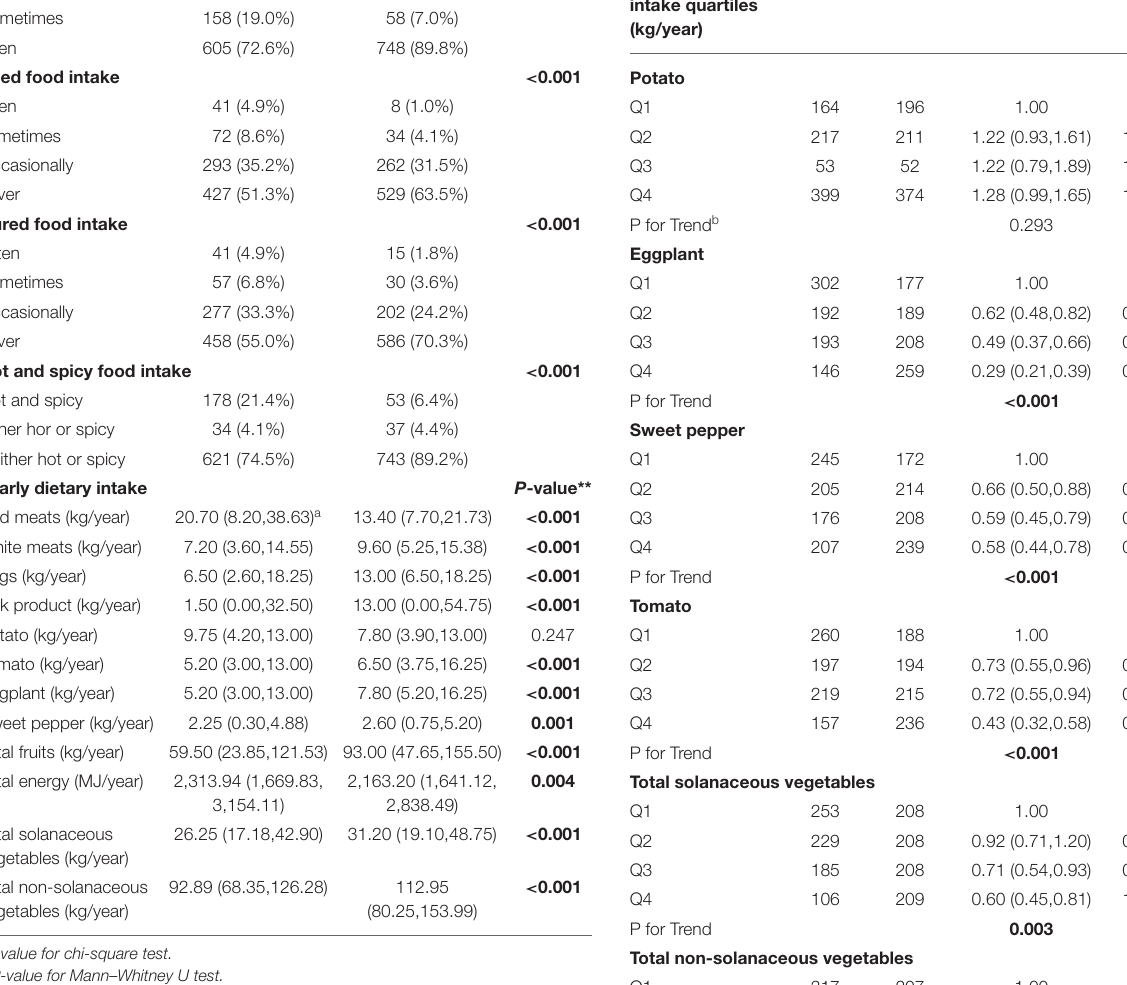
TABLE 3 | Odds ratios (ORs) and 95% confidence intervals (CIs) for the association between solanaceous vegetables intake and colorectal cancer risk. Yearly solanaceous vegetables intake